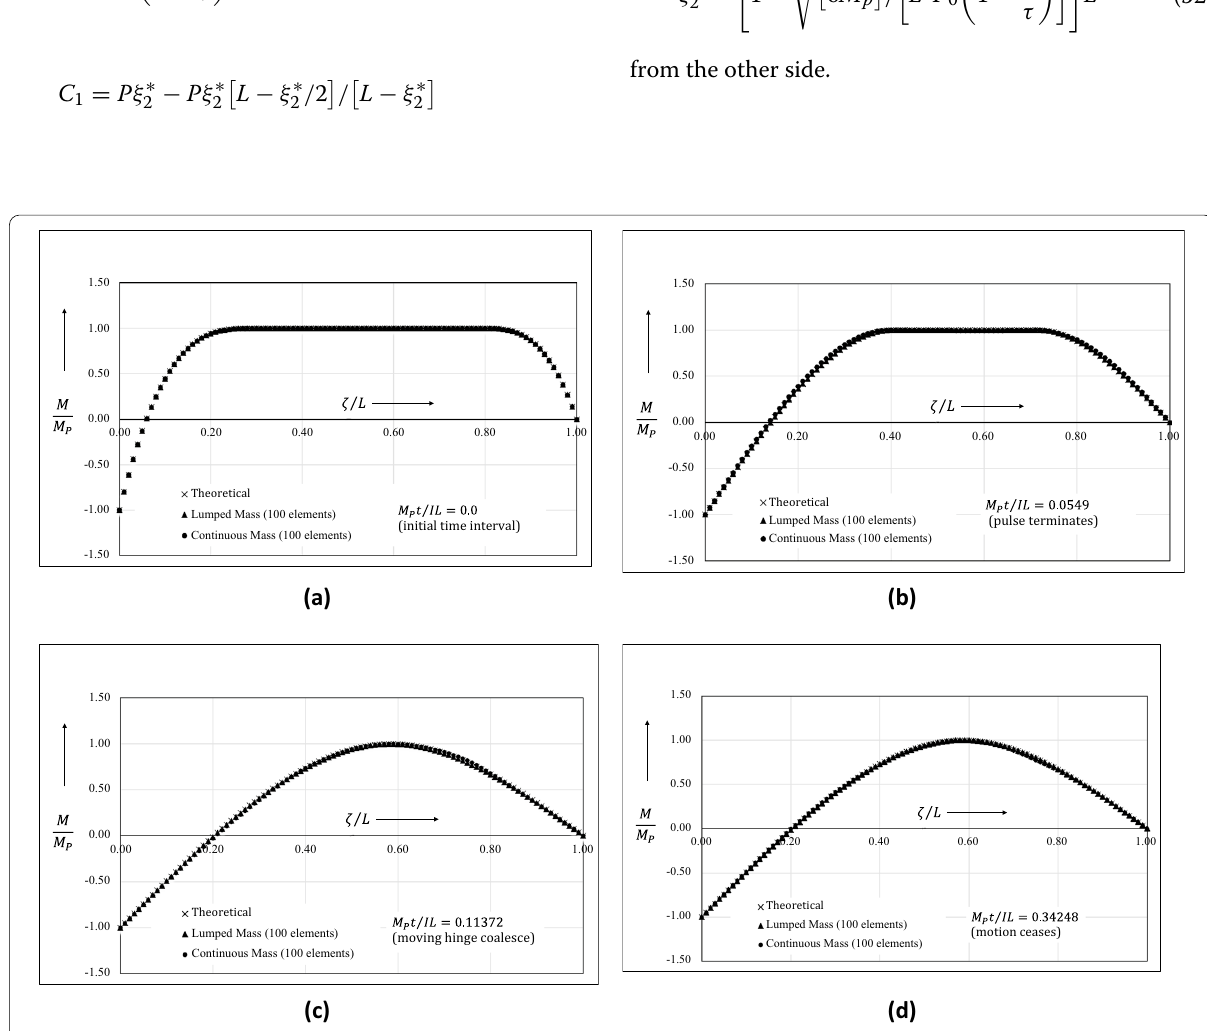
Fig. 16 Dynamic bending moment evolution ( P 0 = 12.5 P c )